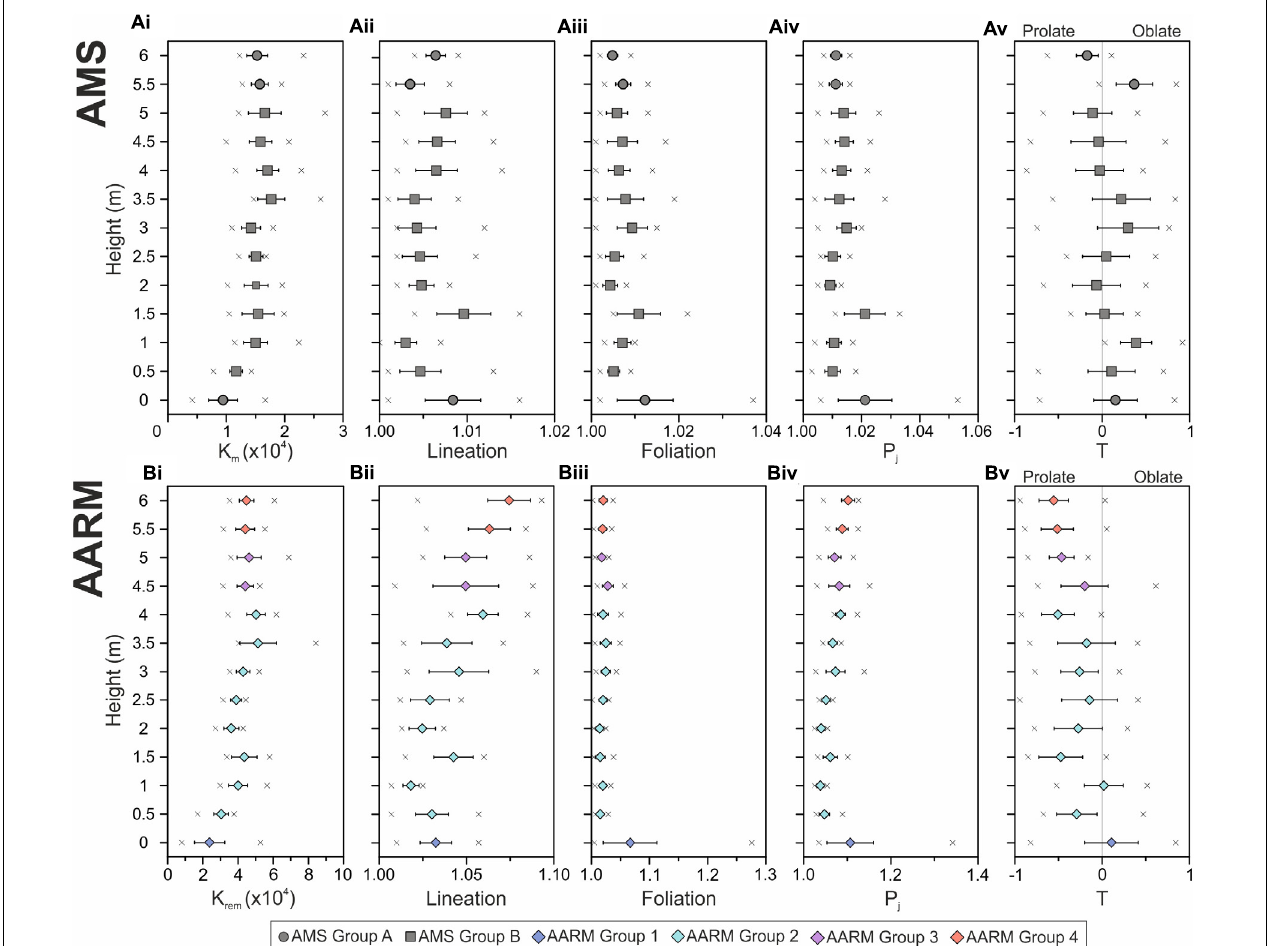
FIGURE 7 | Graphs showing (A) AMS and (B) AARM measurements at specific heights across the crinanite sill thickness: (i) mean susceptibility K m , (ii) lineation, (iii) foliation, (iv) degree of anisotropy P j , and (v) shape parameter T. In all plots the symbol position (square, circle, or diamond) shows the mean measurement, the horizontal error bars show the 95% confidence intervals, and the crosses show the minimum and maximum